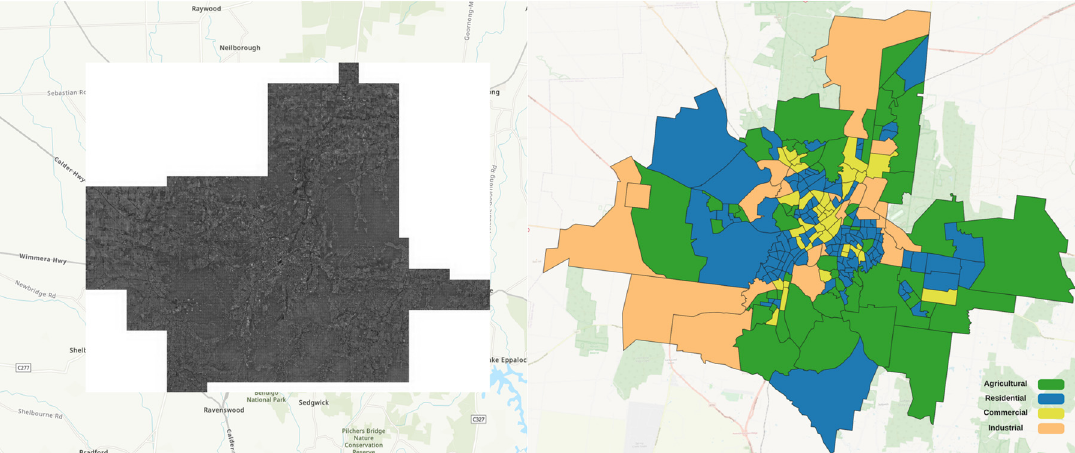
Figure 1. LiDAR coverage in City of Greater Bendigo ( Left ) and the studied SA1s in this project ( Right ).